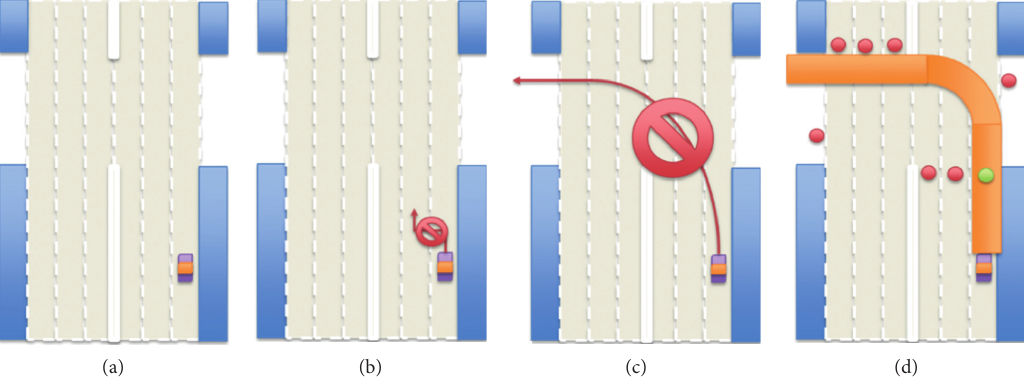
Figure 1: Illustration of the Rail-safe driving logic for road following (a), prohibited lane-changing (b), and left-turning (c). To allow left- turning for a Rail-safe logic, the road needs to be clearly marked and a traffic light inserted with a dedicated aspect for the automated vehicle left-turning which can even turn left from the right lane at this point (d).